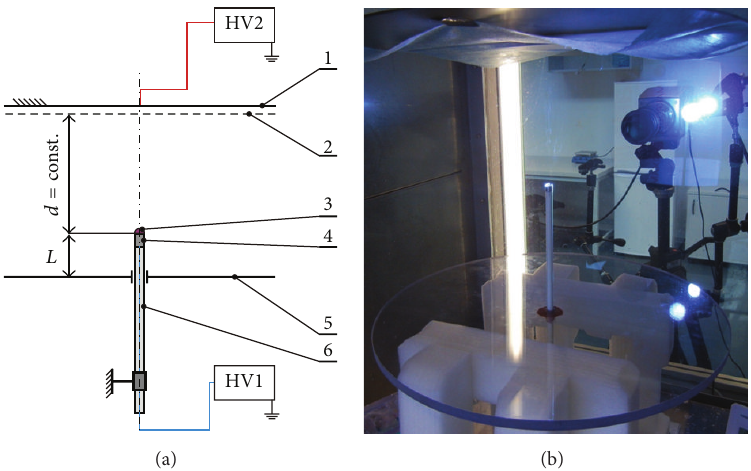
Figure 4: (a) Scheme of the experimental setup and (b) picture of experimental apparatus.